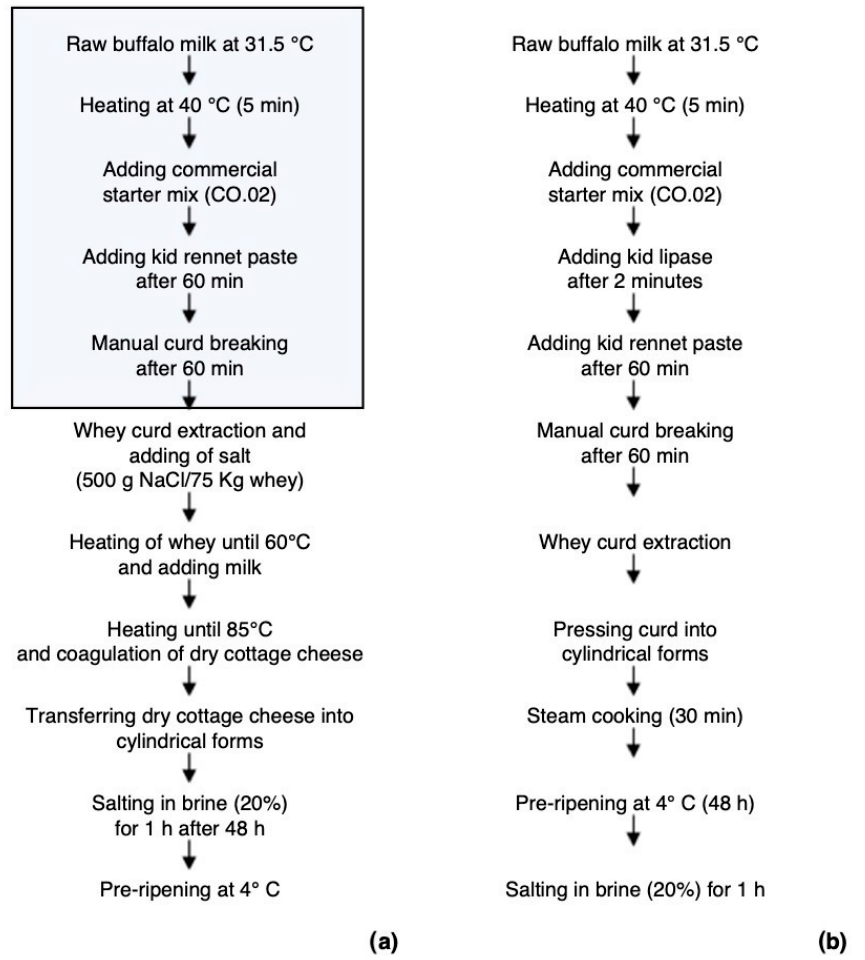
Figure 1. Flow diagrams of buffalo cheeses production of dry ricotta cheese ( a ) and semi-hard cheese ( b ).